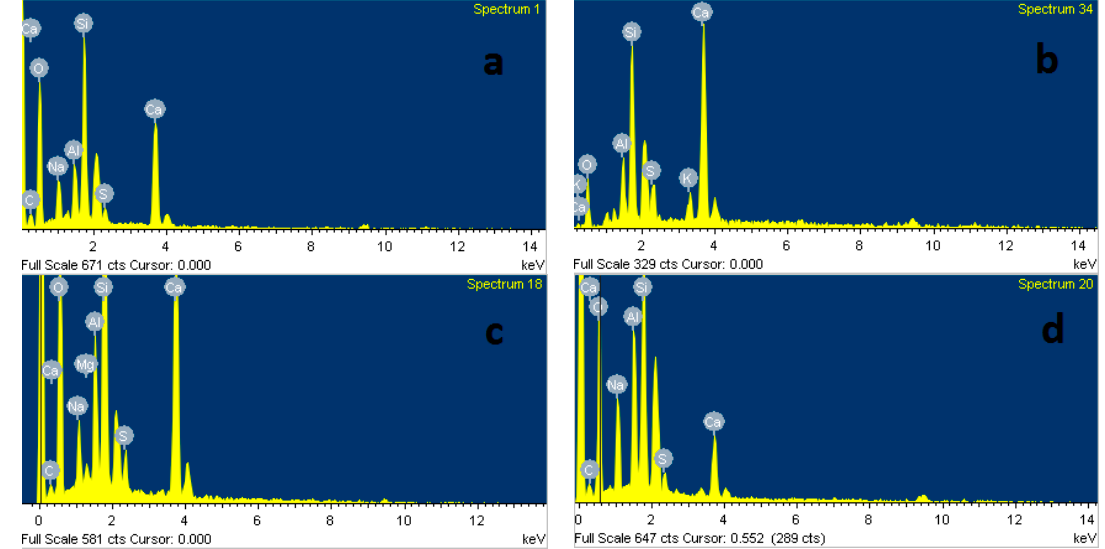
Figure 16. EDS image of: ( a ) Spot labeled 6 in Figure 13; ( b ) Spot labeled 7 in Figure 13; ( c ) Spot labeled 7 in Figure 14; and, ( d ) Spot labeled 7 in Figure 15.